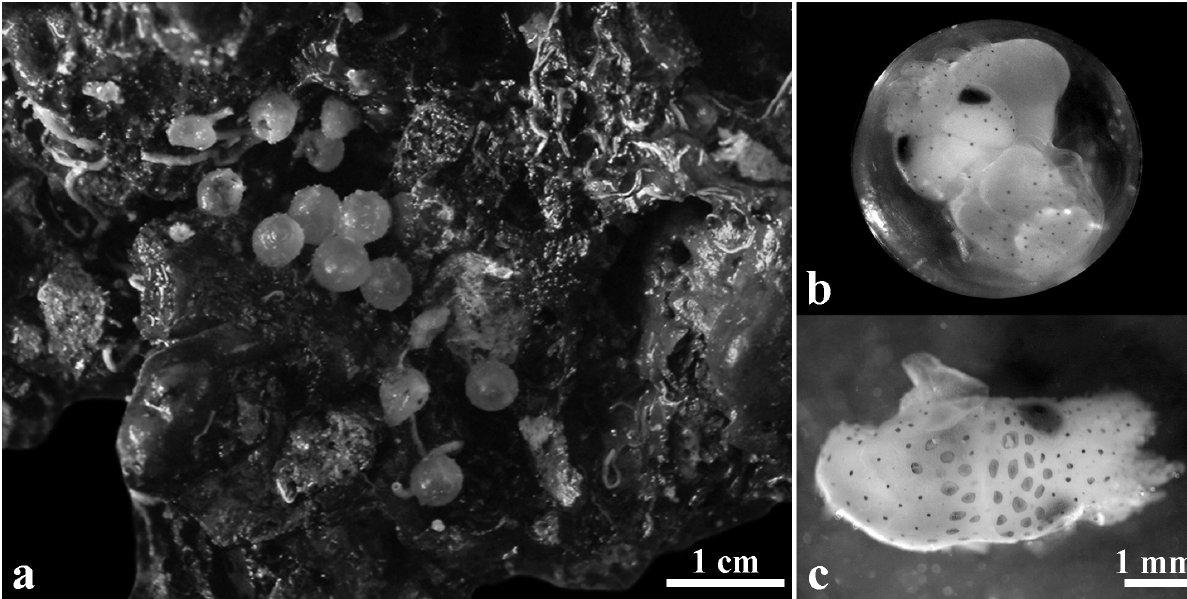
Fig . 1. – Sepietta oweniana from the Sardinian Channel: egg clutch attached to a piece of hard substrate (a); embryo inside the egg (b); newly hatched specimen